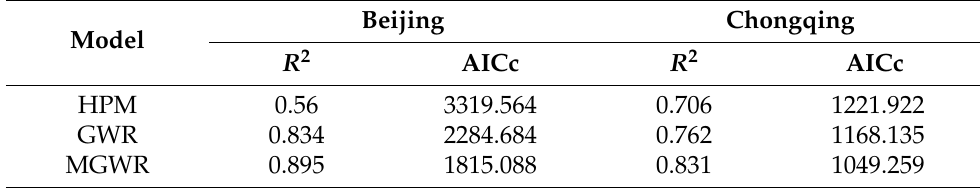
Table 4. Comparison of models.